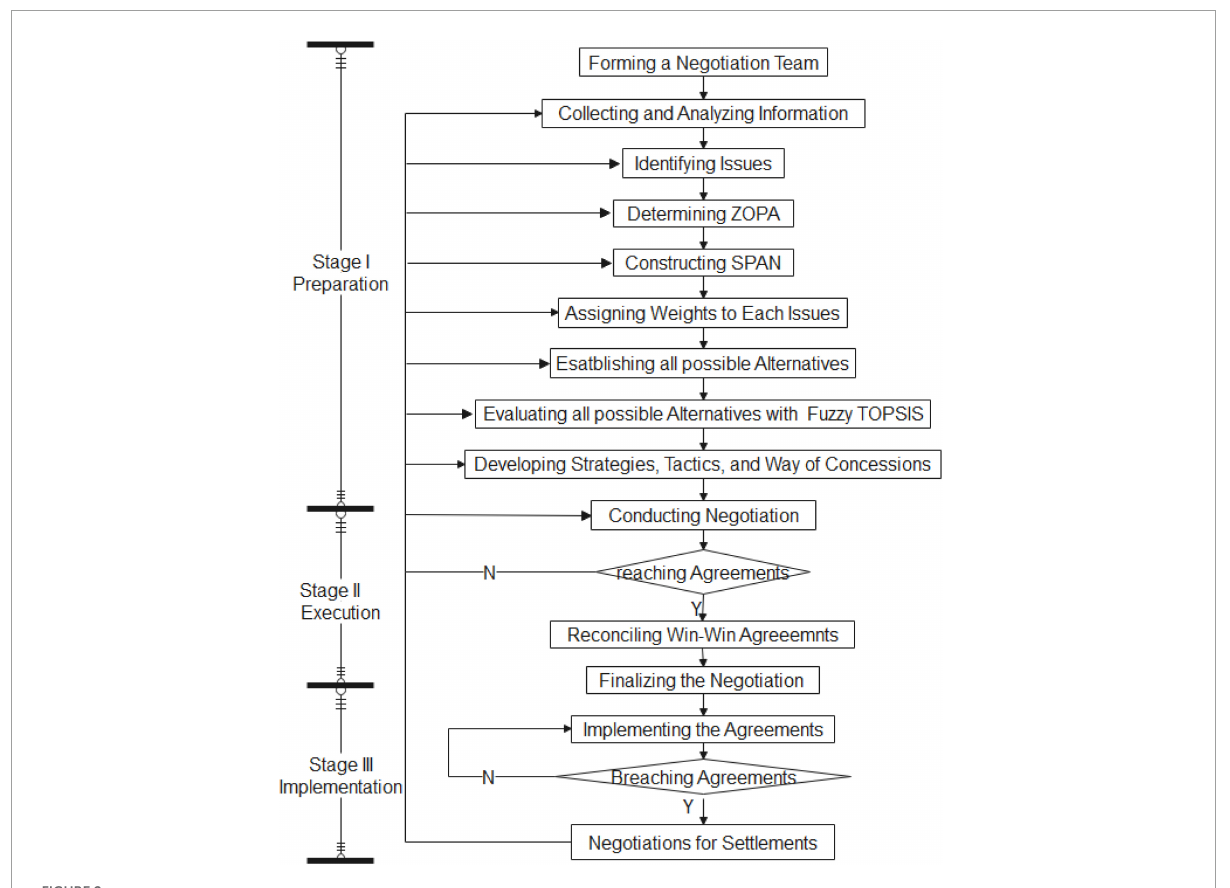
FIGURE2 An integrated model for negotiation in project